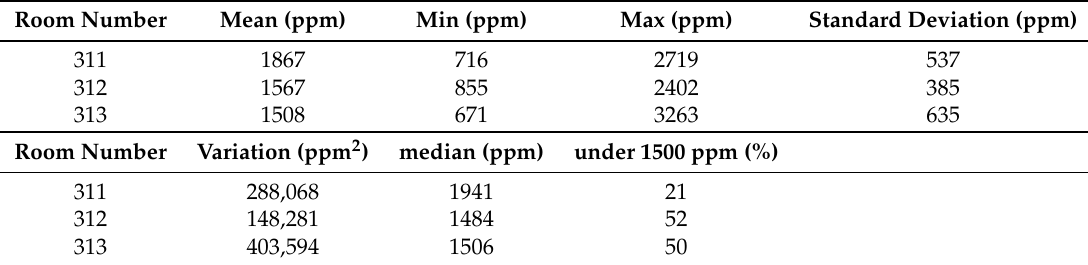
Table 4. Summary of statistical information of the data collected for 15 January 2019 at the